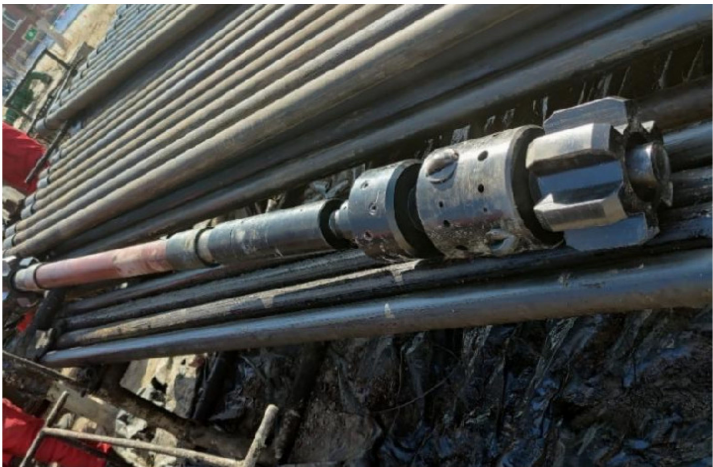
Figure 21. Installation diagram of rotary jet unblock